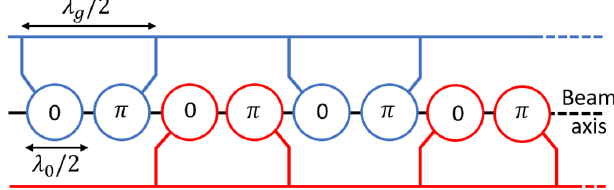
FIG. 1. The distributed feeding network for π -mode linac with two manifolds feeding interleaving pairs of cavities; every two adjacent cavities require a π phase shift, which is provided by successive tap-offs from the manifold, separated by λ